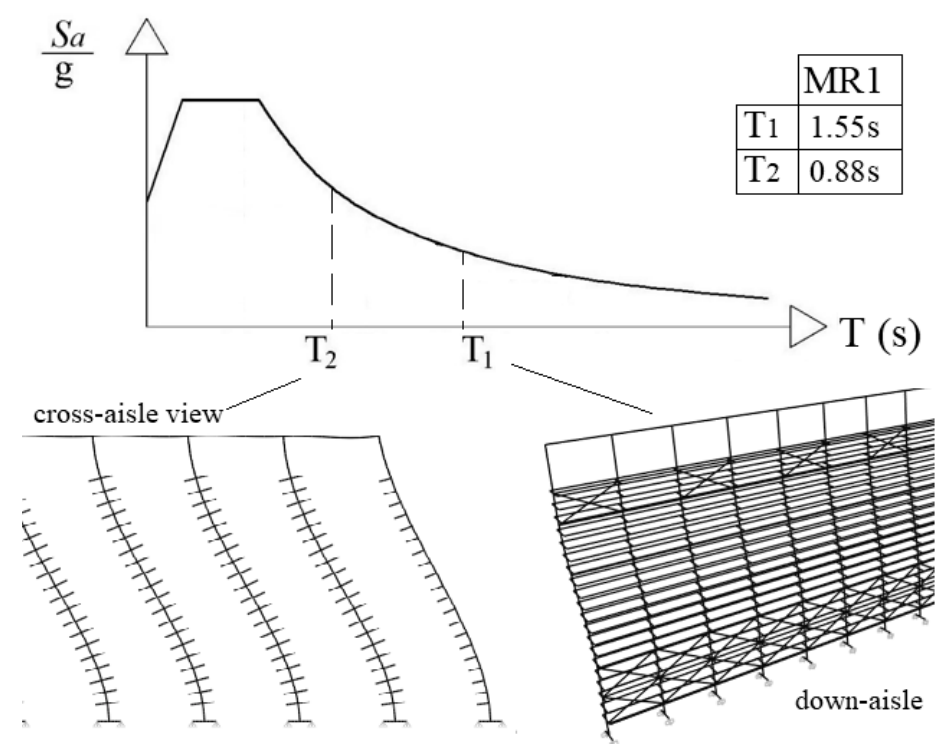
Figure 10. Peak ground accelerations associated with the first two modes of vibration.